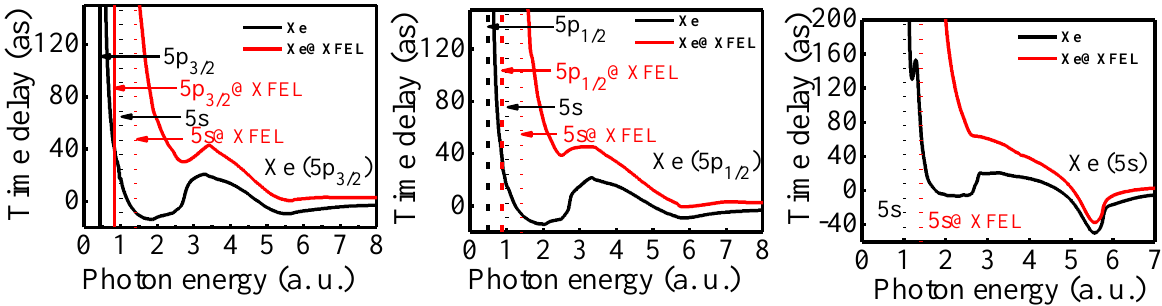
Figure 17. Time delay (τ) of 5p 3/2 (Left), 5p 1/2 (Middle), and 5s (Right) subshells of Xe (black) and Xe@XFEL (red). Solid, dashed, and dotted vertical lines represent the threshold for 5p 3/2 , 5p 1/2 , and 5s thresholds of free (black) and confined atom (red), respectively.